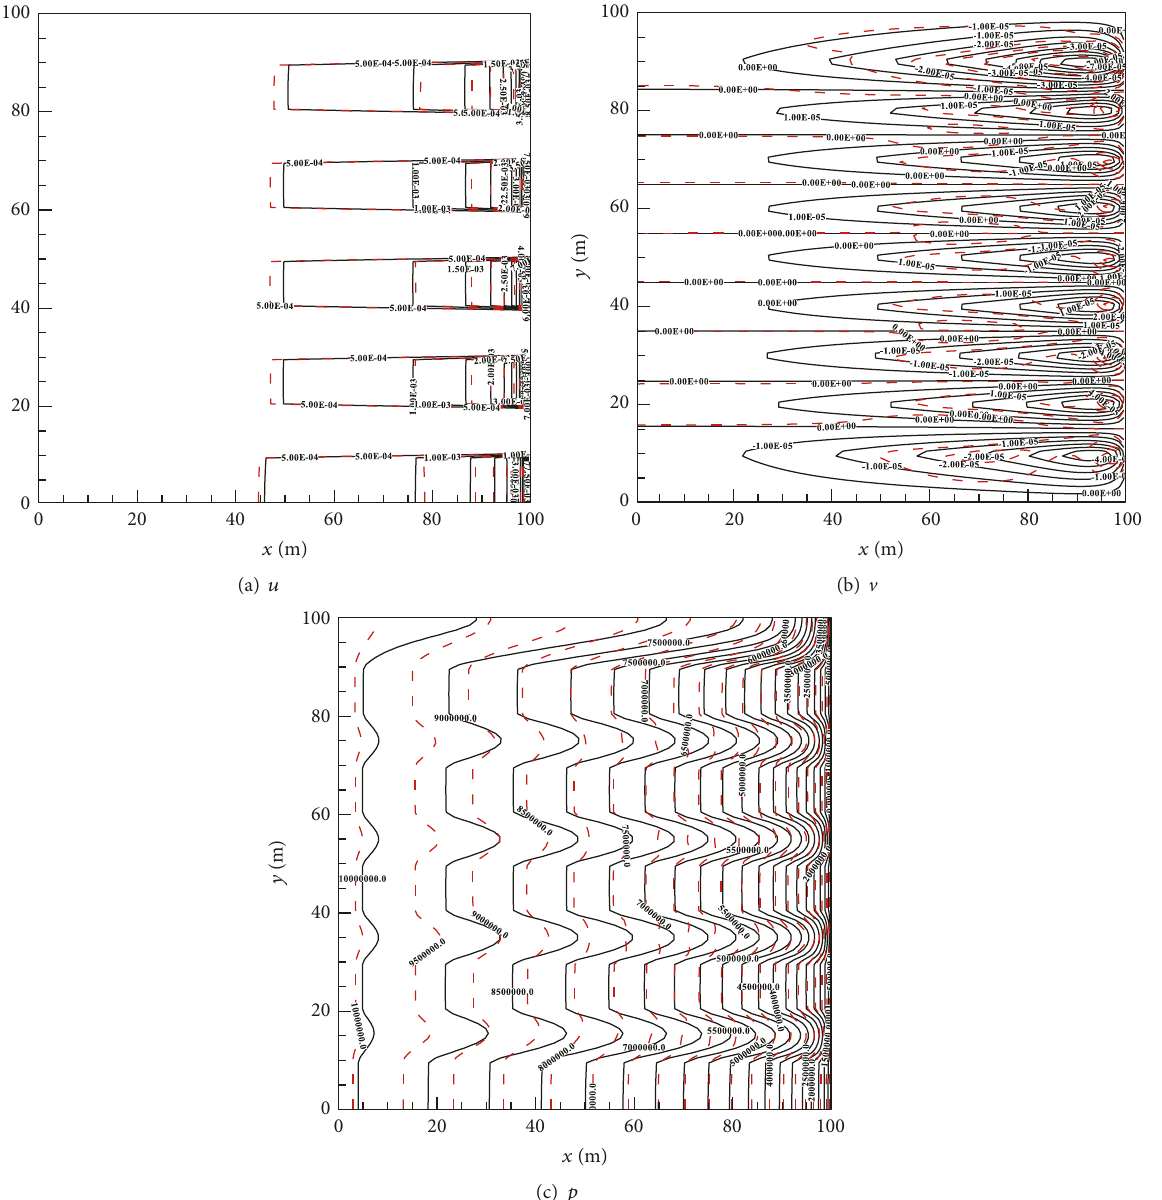
Figure 10: Flow field comparison at the maximum deviation for real gas. Black line: FDM; red dashed line: POD.